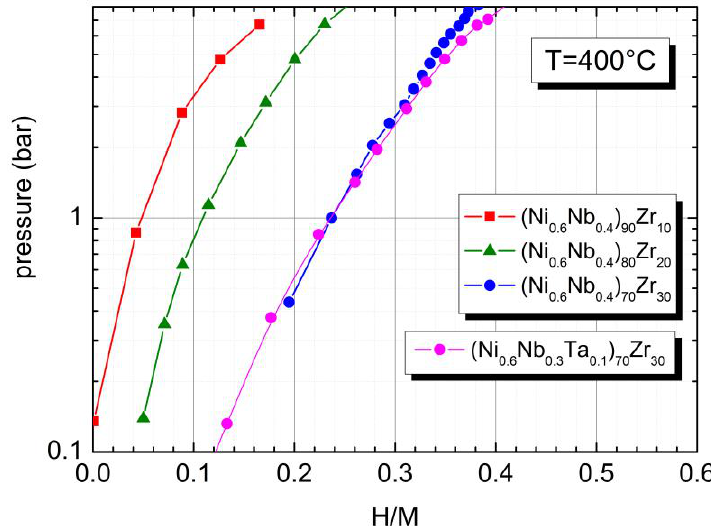
Figure 3. Pressure-composition isotherms measured at 400 ◦ C for (Ni 0.6 Nb 0.4 ) 100 − x Zr x samples as a function of the Zr content. For comparison, also the isotherm of sample (Ni 0.6 Nb 0.3 Ta 0.1 ) 70 Zr 30 is reported.